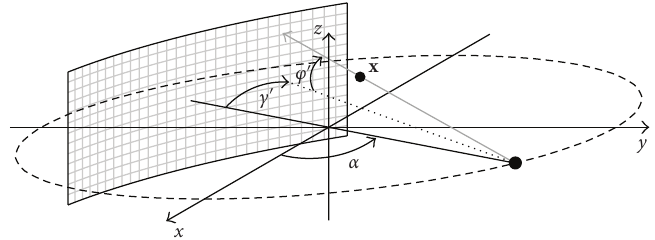
Figure 1: Scheme of a CT scanner in cone-beam geometry with a cylindrical